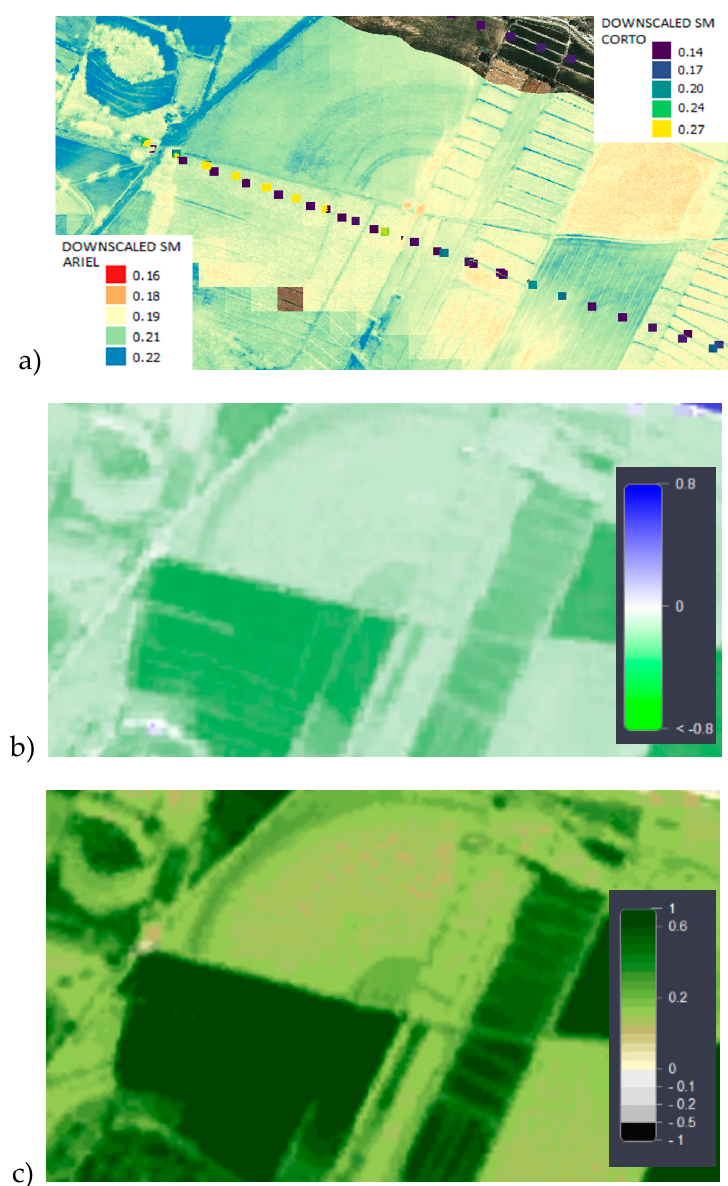
Figure 11. ( a ) Zoom of downscaled ARIEL SM map overlaid with CORTO GNSS-R SM measurements at the Balaguer airborne experiment site, incidence angles between 15 ° and 30 ° for October 22nd, 2018; and Sentinel-2 L1C ( b ) Normalized Difference Water Index (NDWI) and ( c ) NDVI for October 23rd, 2018. Region corresponds to left half of rectangle A in Figures 8, 9, and 10.